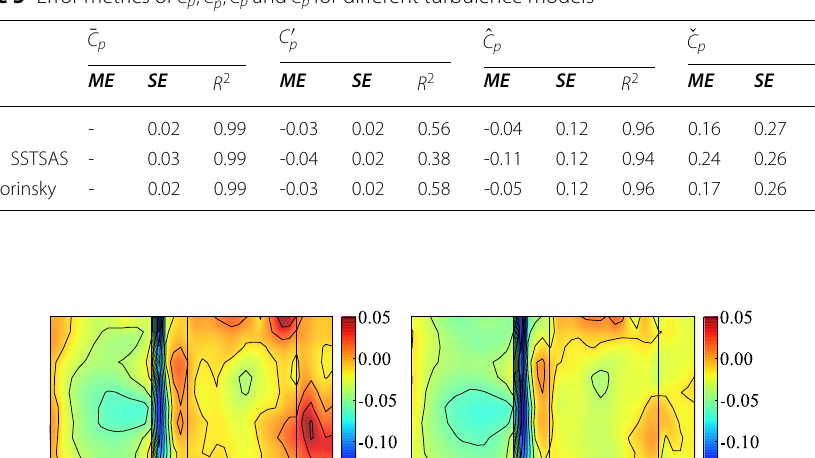
Table 5 Error metrics of ¯ C p , C ′